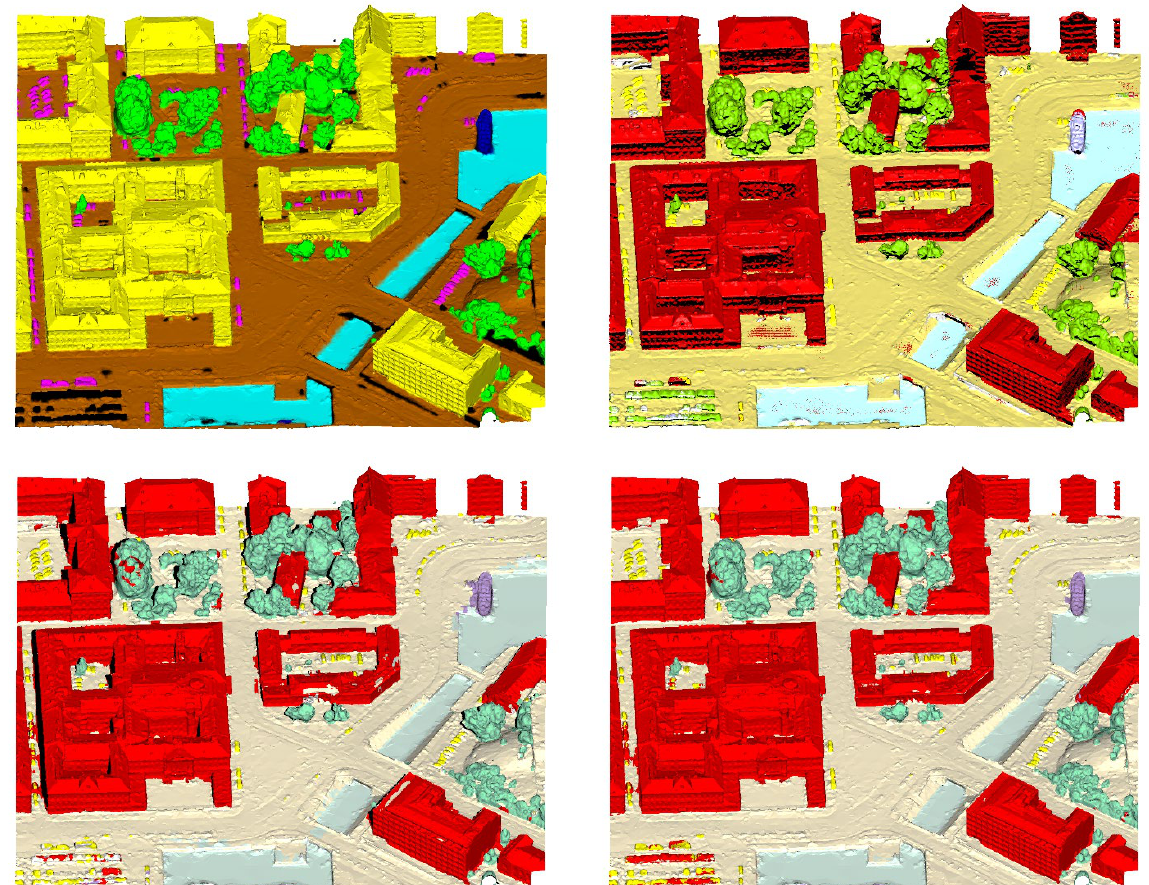
Figure 5 . One of the SUM Benchmark’s test tiles, with the texture generated from reference data (top - left), point cloud classified with OPEGIEKA’S CNN (top - right), results from semantic segmentation of single image - occluded areas are black (bottom - left), results of merging classification from many oblique images (bottom -